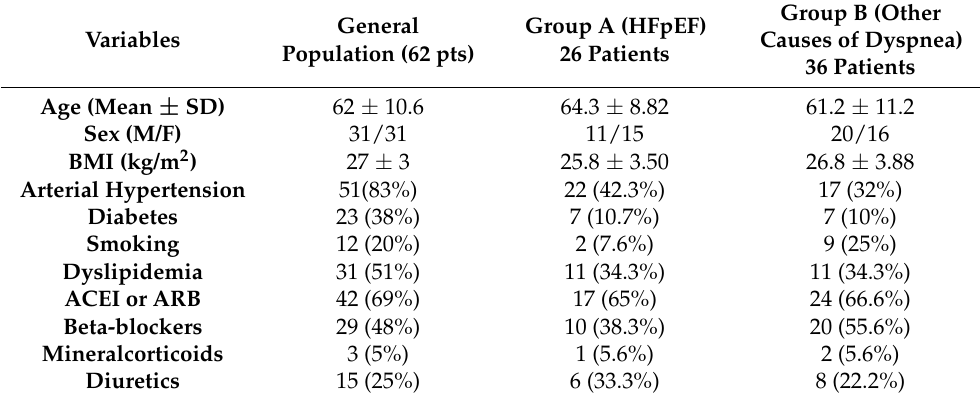
Table 1. Clinical characteristics of the population.